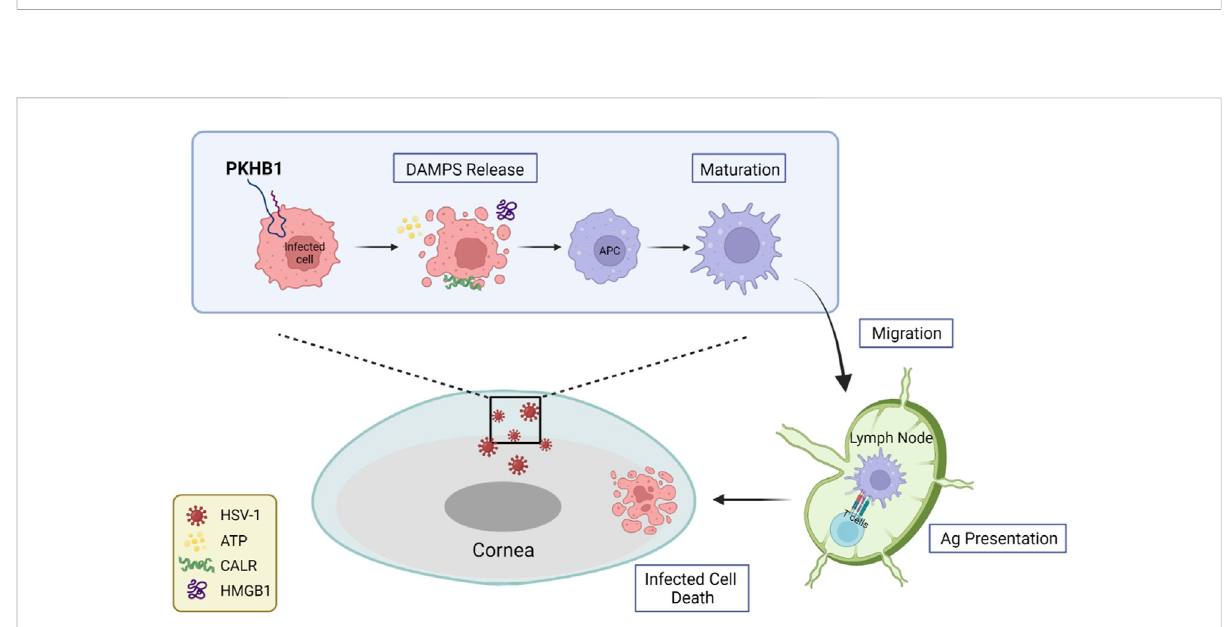
FIGURE 7 Schematic representation of PKHB1-mediated ICD. PKHB1 peptide promoted the recruitment and maturation of APCs by inducing the release of large amounts of DAMPs from infected cells. APCs that phagocytized antigenic materials transferred to the dLNs and triggered cytotoxic T lymphocyte-dependent immune responses, ultimately killing infected cells to alleviate